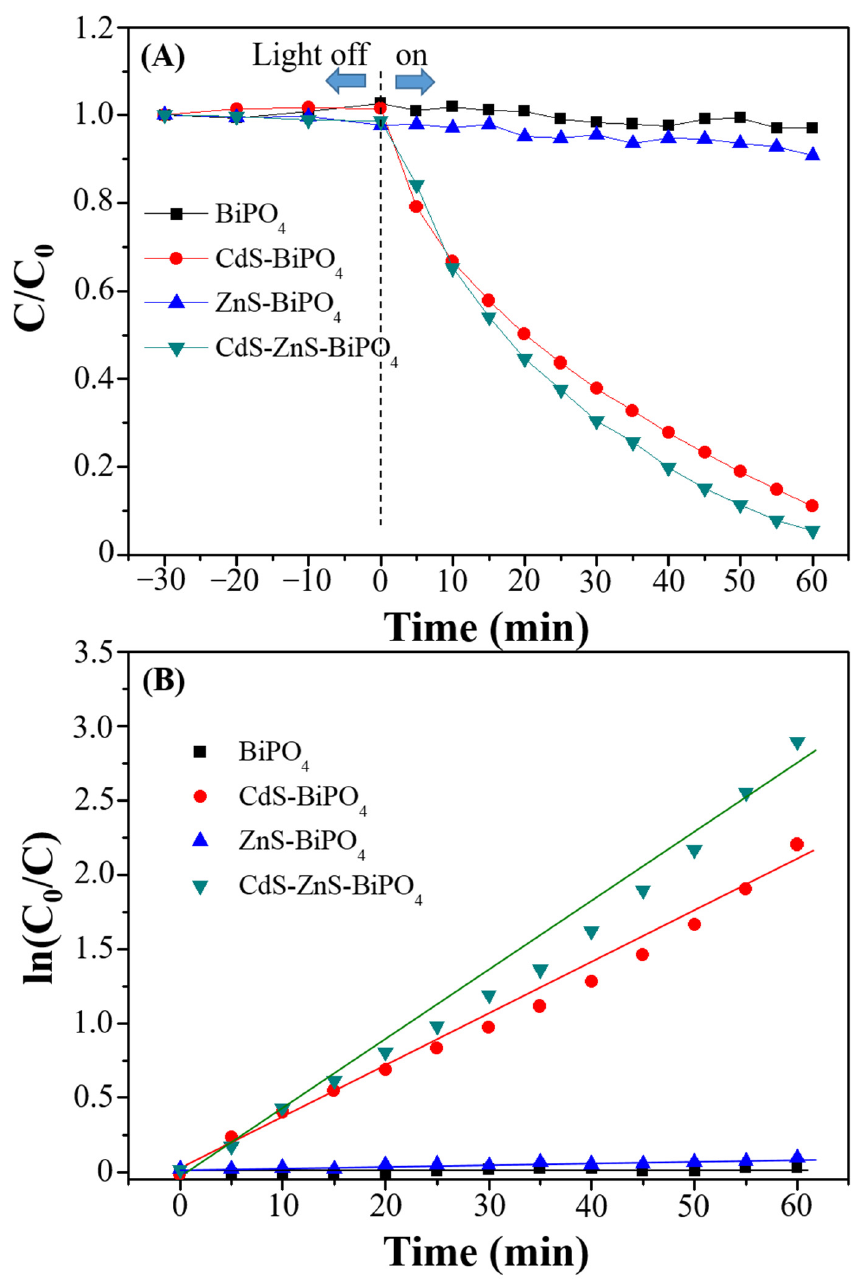
Figure 4. ( A ) Degradation of MB (C/C 0 ) over time and ( B ) the corresponding pseudo-first order linear transform of MB degradation rate in the presence of BiPO 4 (black), CdS-BiPO 4 (red), ZnS-BiPO 4 (blue), and CdS-ZnS-BiPO 4 (olive) nanocomposites under visible light irradiation.